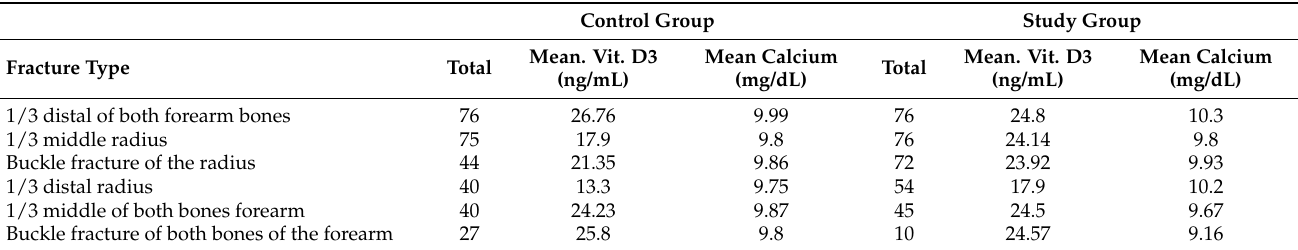
Table 3. Patient distribution according to the most frequent fracture type encountered, study groups, and the mean levels of vitamin D and calcium. Only the first six types of fractures based on the total number of occurrences are